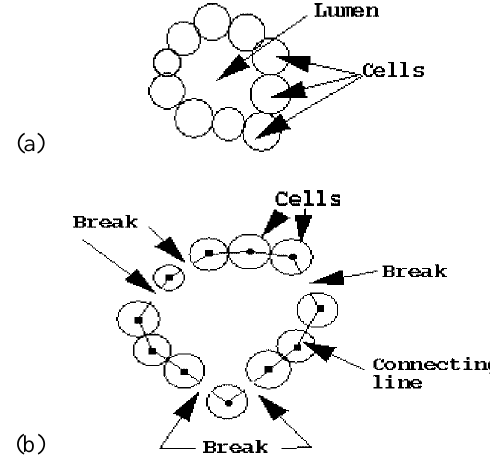
Fig. 3. Diagrammatic representation for quantifying the ring like architecture of prostate tissue glands. (a) A complete glandular arrangement of the cells (b) break in the glandular arrangement of the cells, This figure can be viewed on http://www.esacp.org/acp/